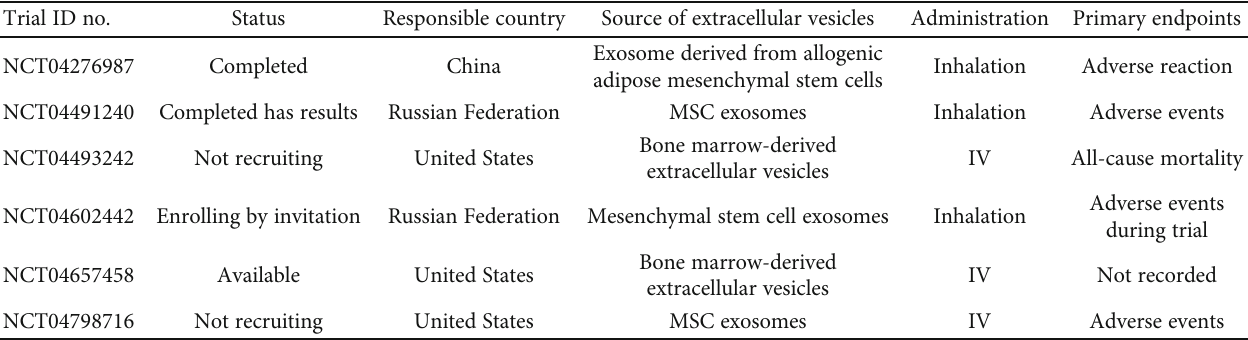
Table 3: MSC-EV treatment trials in COVID-19 registered on Clinical Trials. The treatment of COVID-19 disease, including trial numbers, source of EVs, routes of administration, and primary endpoints. Trial ID